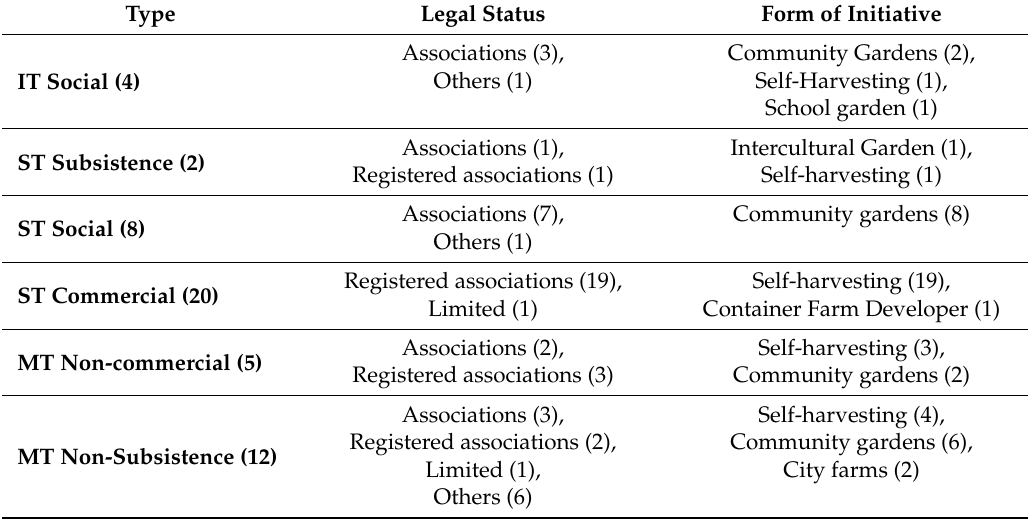
Table 4. Mapping of Legal Status and Self-Designation to Calculated Types with IT = Ideal Type, ST = Subtype and MT = Mixed